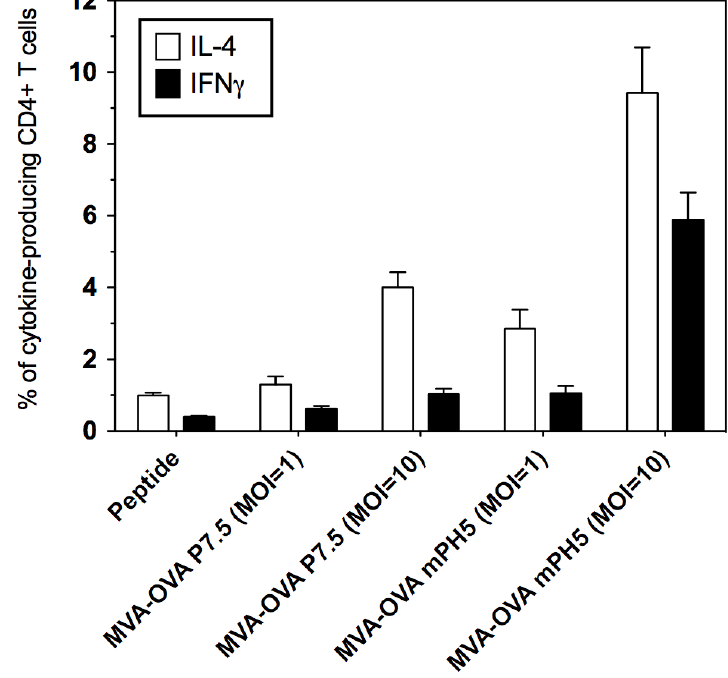
Figure 5. Cytokine production in an in vitro Ag presentation test by DCs infected with MVA-OVA. DCs were infected for 6 h with MVA-OVA P7.5 and MVA-OVA mPH5 at a MOI of 1 or 10. After infection, DCs were cultured with naïve CD4 + T cells from OT-II mice. At day 5 intracellular staining was carried out for IL-4 and IFN-γ. OVA peptide AA323–339 was used as a